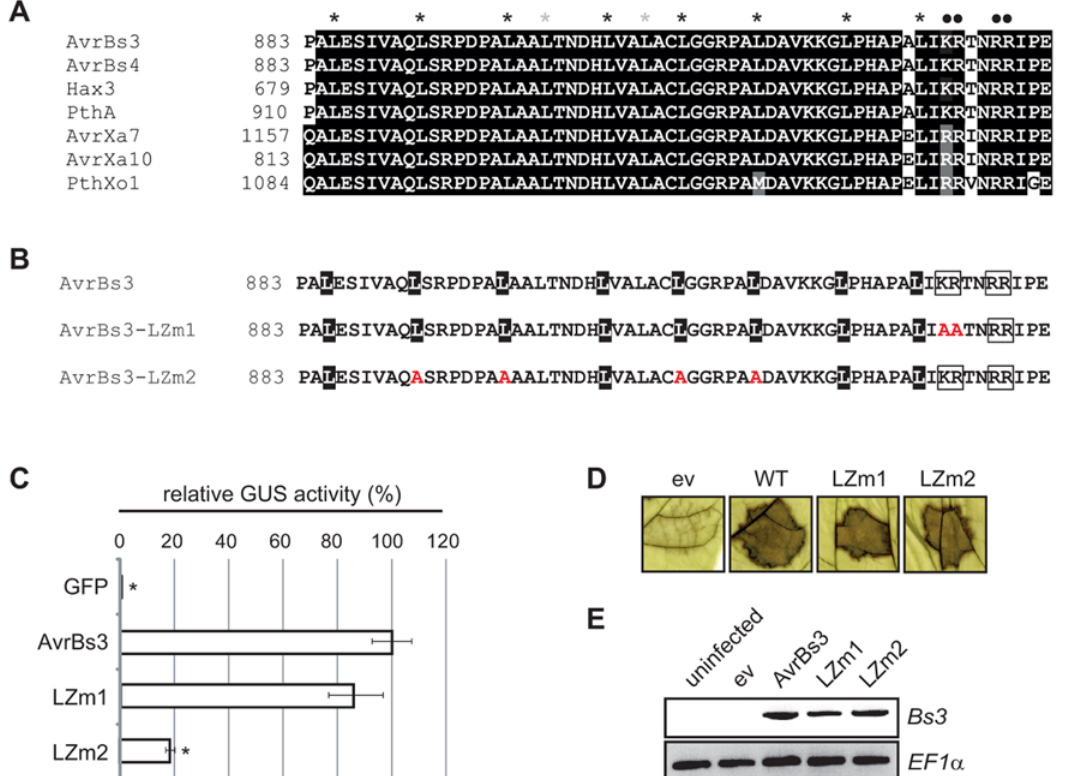
Fig 6. Analysis of the imperfect leucine zipper motif in AvrBs3. ( A ) Sequence comparison between the leucine zipper-like motif in the CTR of AvrBs3 and a subset of homologs using ClustalW. Identical amino acids (white letters on black background) and similar amino acids (white letters on grey background) were shaded using Boxshade. Leucines corresponding to the proposed leucine repeats were labelled with a black asterisk, leucines that do not correspond to leucine repeats with a grey asterisk and aa of the basic region with a black dot. (B) AvrBs3 was mutated in the basic region (AvrBs3-LZm1) and in leucines of the leucine-rich region (AvrBs3-LZm2). Leucines are given in black, the basic regions are boxed. (C) UPA20 box activation by AvrBs3 and AvrBs3 mutant derivatives shown in B. GUS activities were determined in leaves of N . benthamiana three days after Agrobacterium -mediated co-delivery of the reporter construct ( UPA20 box-minimal p Bs4 driving a promoterless uidA [48]), together with silencing inhibitor p19 and gfp , avrBs3 or avrBs3 derivatives. GUS activities are given relative to the GUS activity induced by WT AvrBs3. Error bars indicate SD. Asterisks indicate statistically significant differences as compared to WT AvrBs3 ( t -test, P < 0.05). (D) HR induction by AvrBs3 and mutant derivatives in Bs3 ECW-30R plants. Xcv 85 – 10 containing pGGX1 (empty vector, ev) or pGGX1 driving expression of avrBs3 , avrBs3- LZm1 and avrBs3- LZm2, respectively, were inoculated into leaves of Bs3 pepper plants (ECW- 30R). Leaves were harvested three dpi and bleached with ethanol to better visualize the HR. (E) Bs3 gene induction by AvrBs3 and mutant derivatives in leaves of pepper ECW-30R. RT-PCR analysis 10 h after inoculation of the Xcv strains described in D. EF1 α was used as control for equal cDNA amounts. RT-PCR was repeated once, the other experiments at least twice with similar